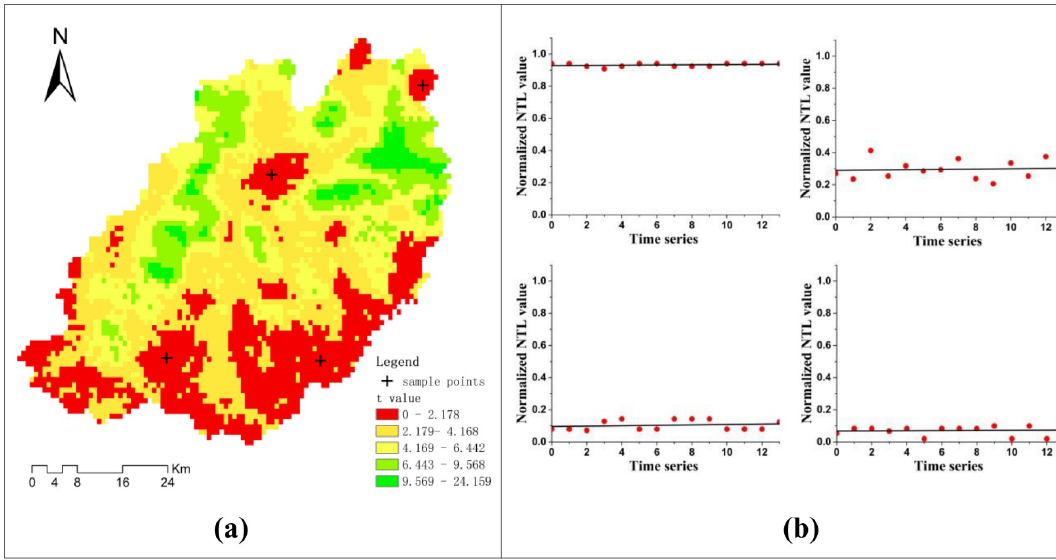
Fig 11. T-test values of time series normalized NTL linear fitting. (a) the spatial distribution map of t-test values. (b) examples of NTL linear fitting at sample points with low t-test values.